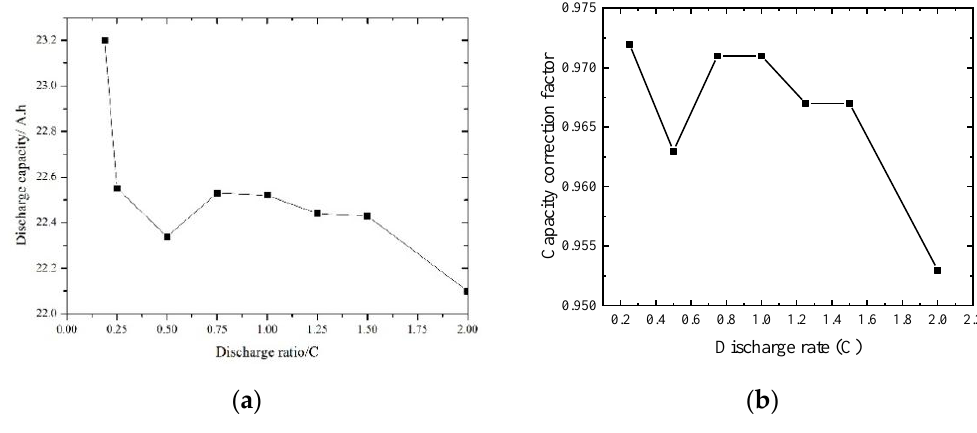
Figure 5. Correction factors at different discharge ratios.